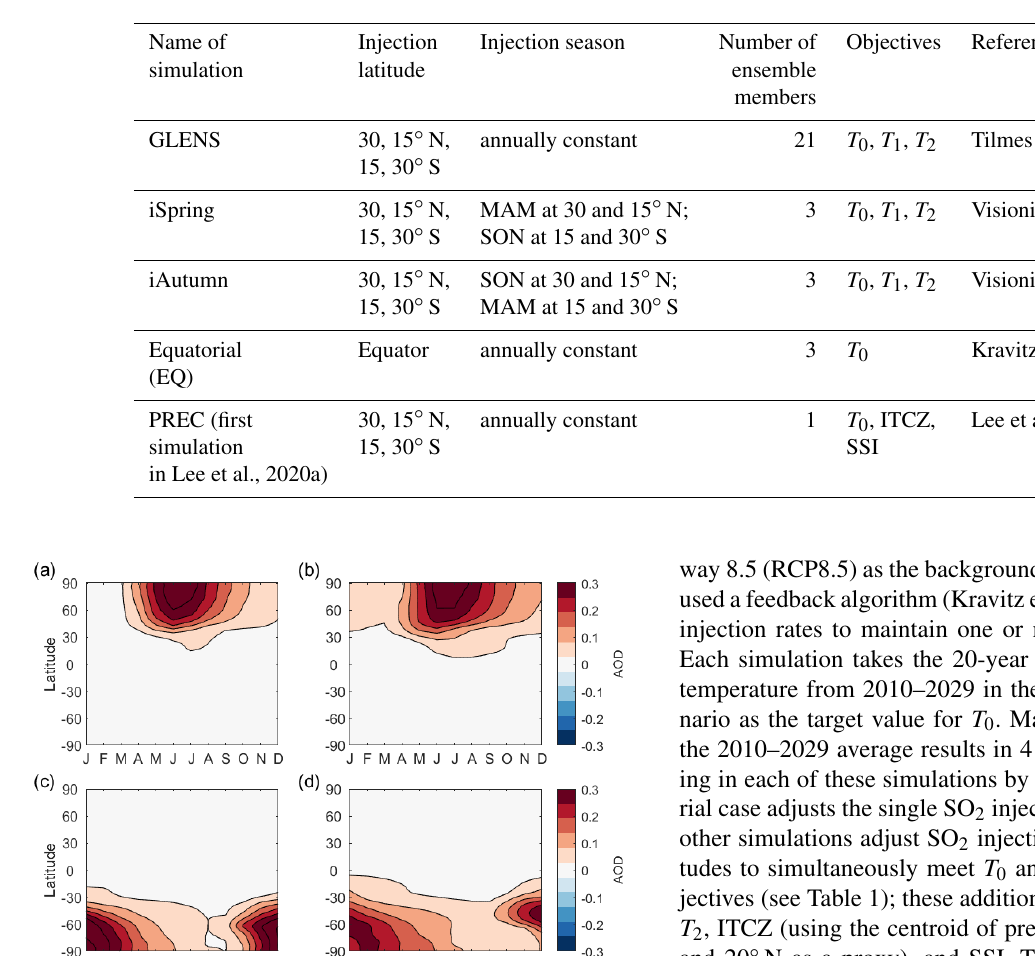
Table 1. Injection design of the five existing SAI simulations analyzed in this study.